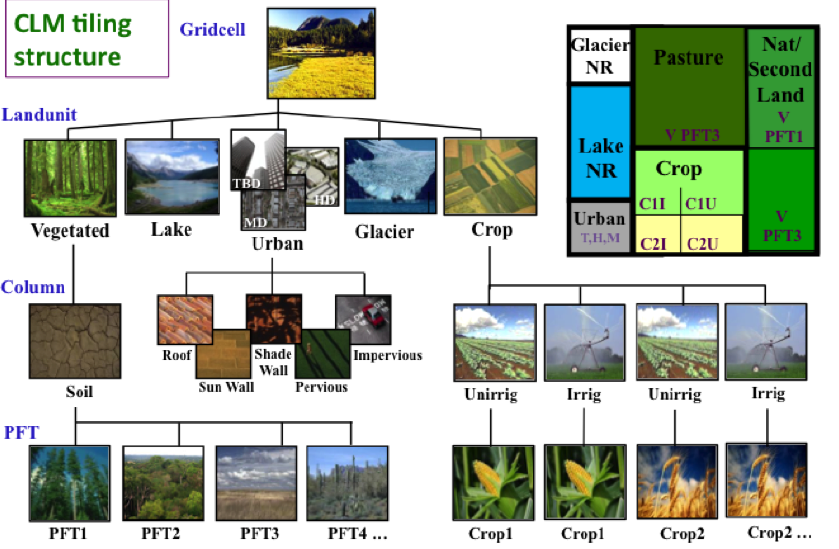
Figure 9. CLM tiling structure (Fig. 8, Oleson et al., 2013). Subgrid aggregation: PSL: vegetated land unit including all PFTs and bare soil; CRP: crop land unit including all crop types irrigated (I) and non-irrigated (U); PST: not explicitly represented in CLM, reported as a missing value; URB: weighted average of the Tall Building District, High Density, and Medium Density types in Urban land unit. Glacier and Lake are not